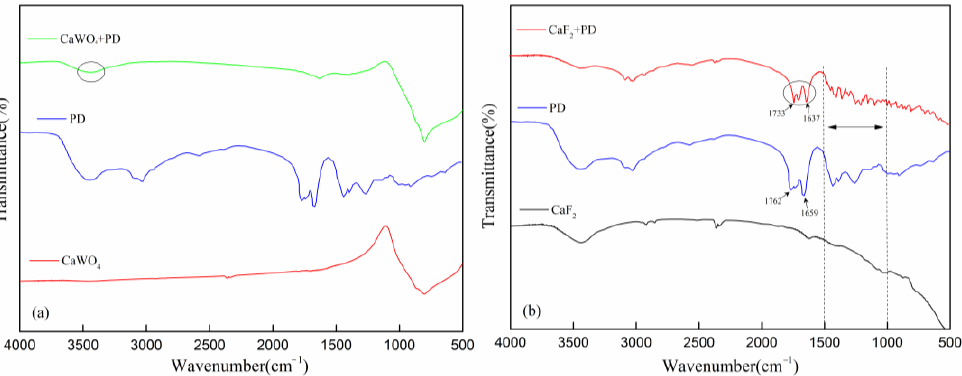
Figure 7. FTIR spectra of ( a ) scheelite and ( b ) fluorite before and after interaction with PD.